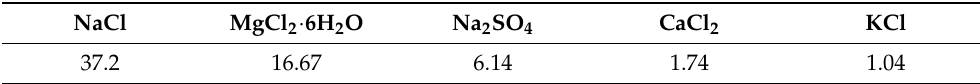
Table 2. Chemical compositions of the artificial seawater,